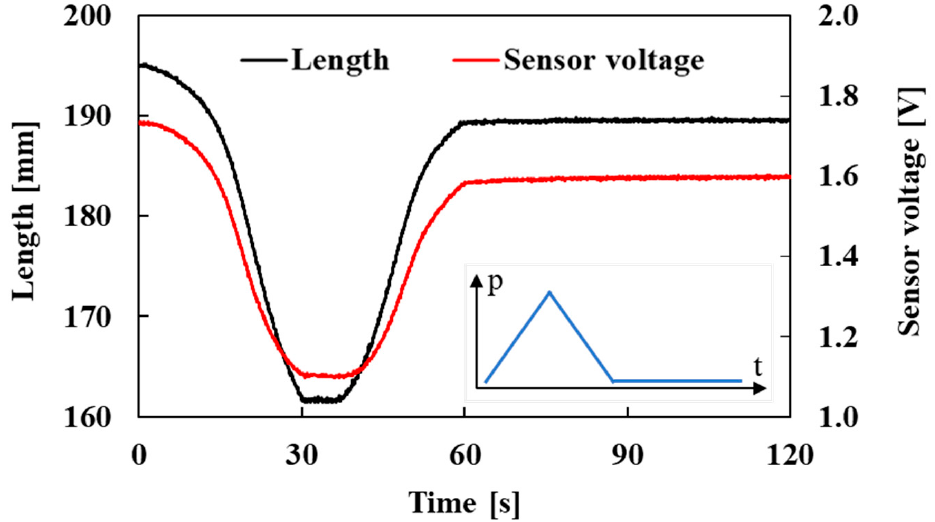
Figure 14. Length and sensor voltage variation with respect to time (pneumatic pressure: 0.0 MPa → 0.3 MPa → 0.0 MPa, then held until 120 s).